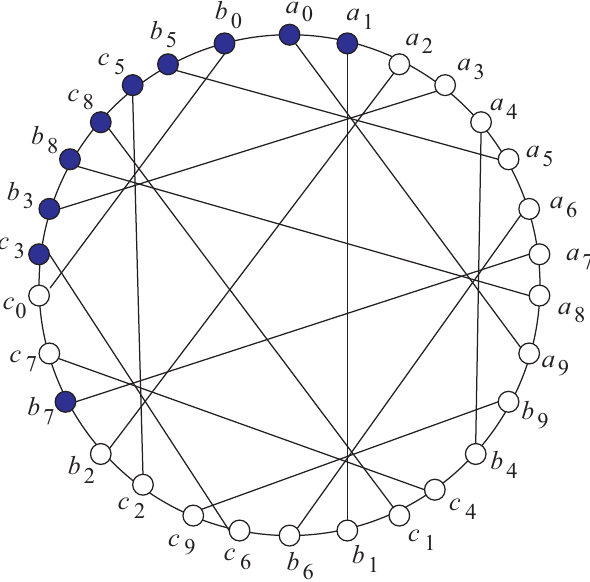
Figure 9: Tutte-Coxeter graph with a zero forcing